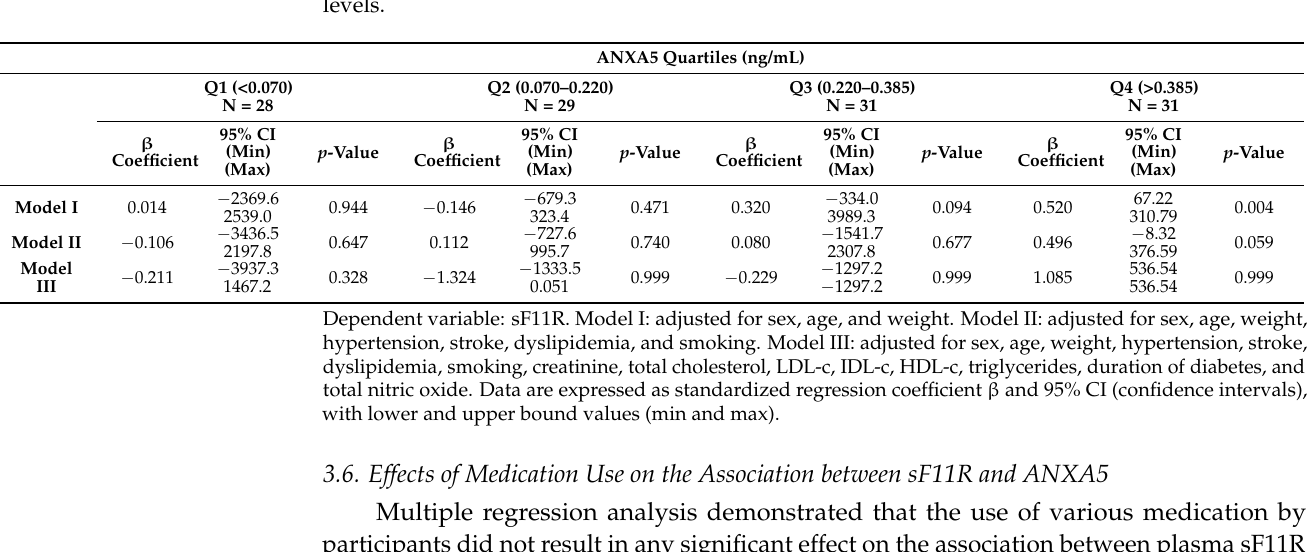
Table 6. Association between sF11R and ANXA5 according to quartiles of circulating plasma ANXA5 levels.